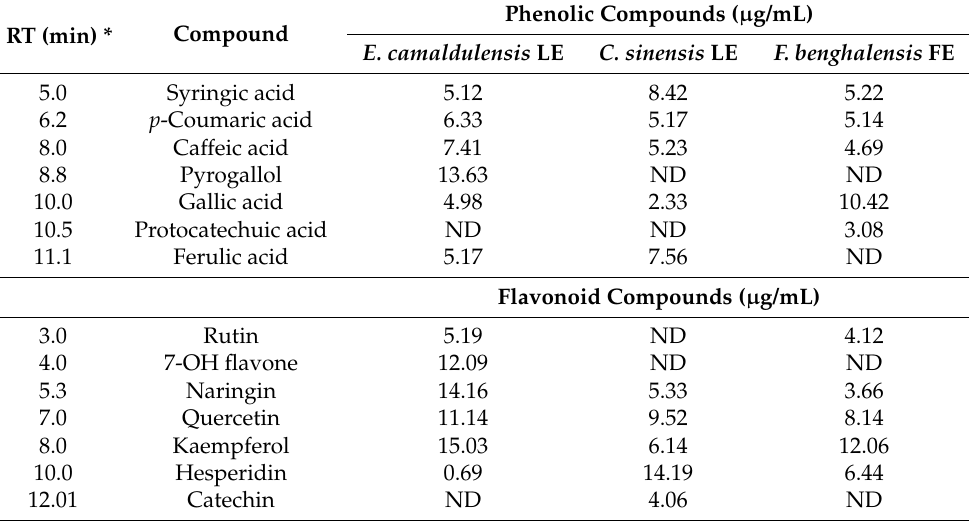
Table 3. Phenolic and flavonoid compounds identified in E. camaldulensis LE, C. sinensis LE, and